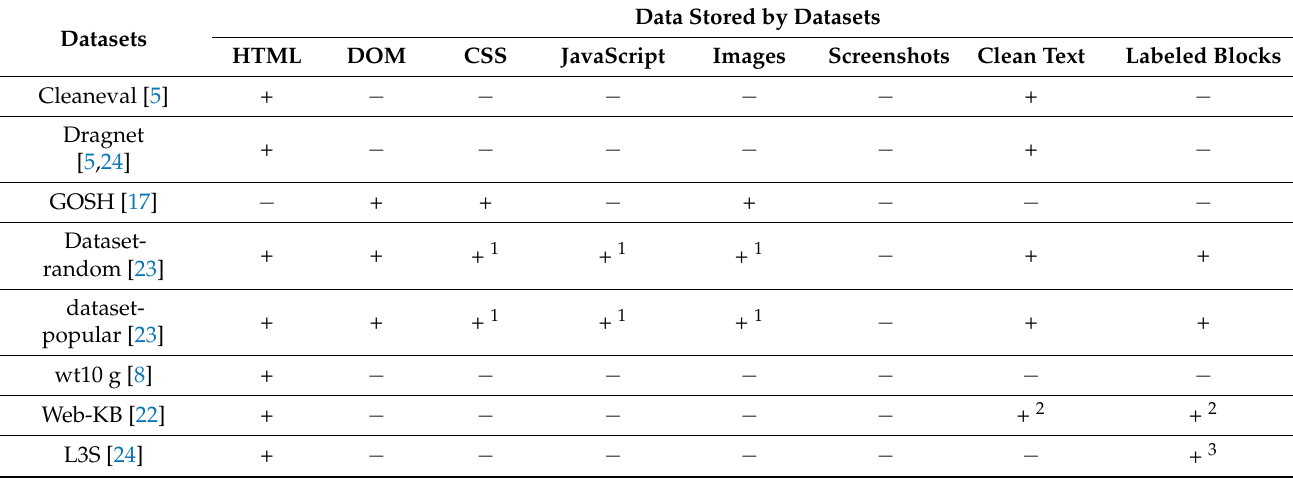
Table 1. Comparison of data stored by